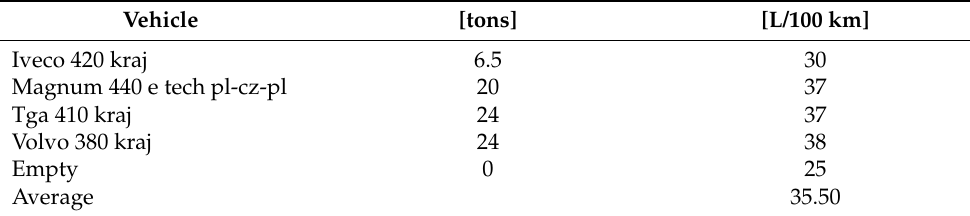
Table 8. Transport rates—2011 for a tractor with a